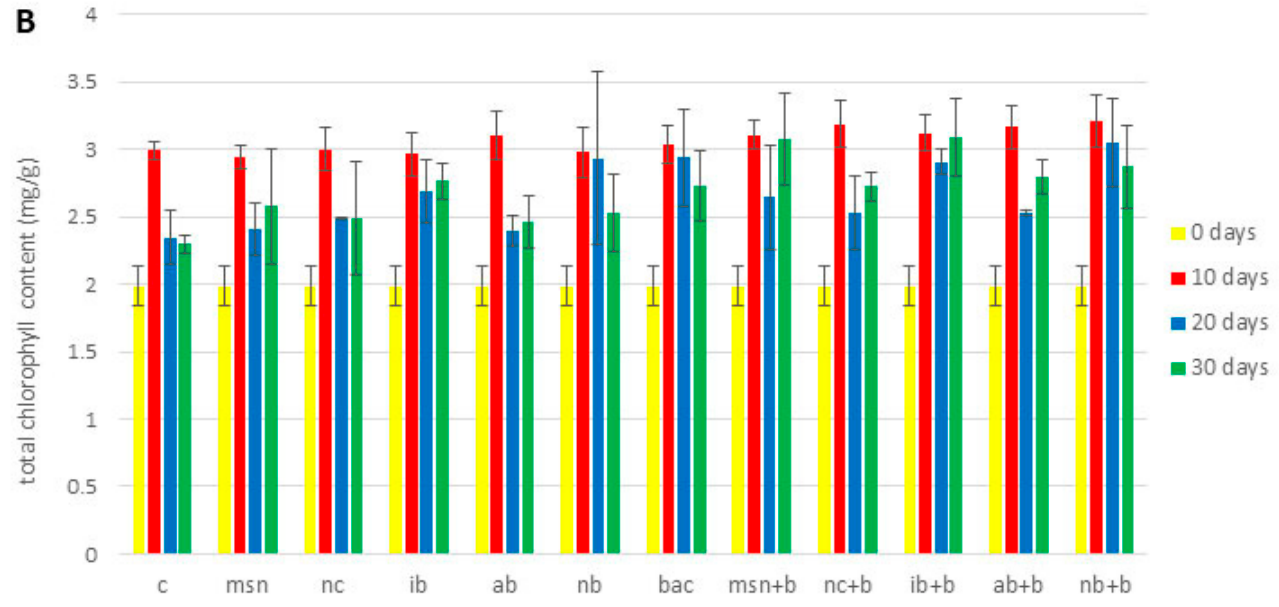
Figure 1. Total chlorophyll content (mg/g fresh mass). ( A ) 2nd tomato experiment; ( B )